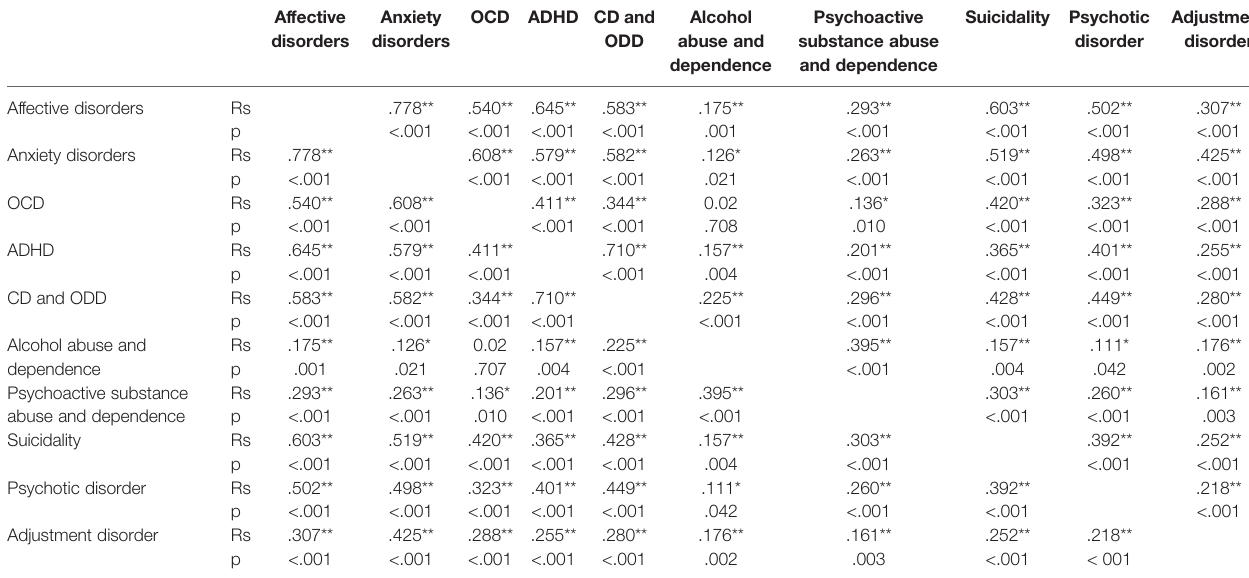
TABLE 5 | Correlations of M.I.N.I Kid